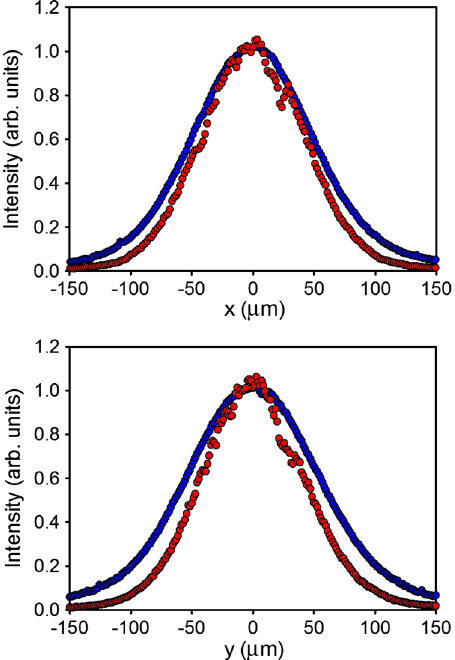
FIG. 10. Horizontal (top) and vertical (bottom) projections of beam images measured in the visible (blue dots) and the EUV (red dots) spectral region. To aid the comparison, the data are normalized to the peak value.